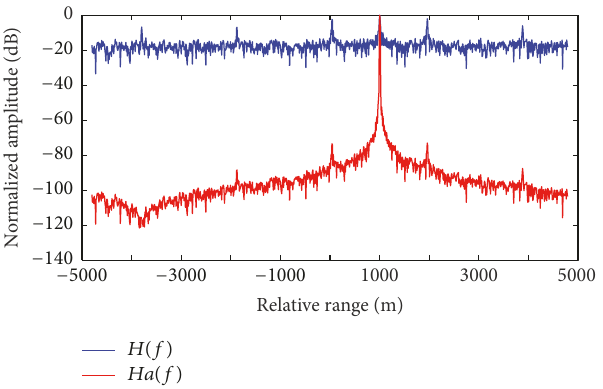
Figure 5: The band-pass filtering function ( 𝑇 𝑠 = 2 𝜇 s).